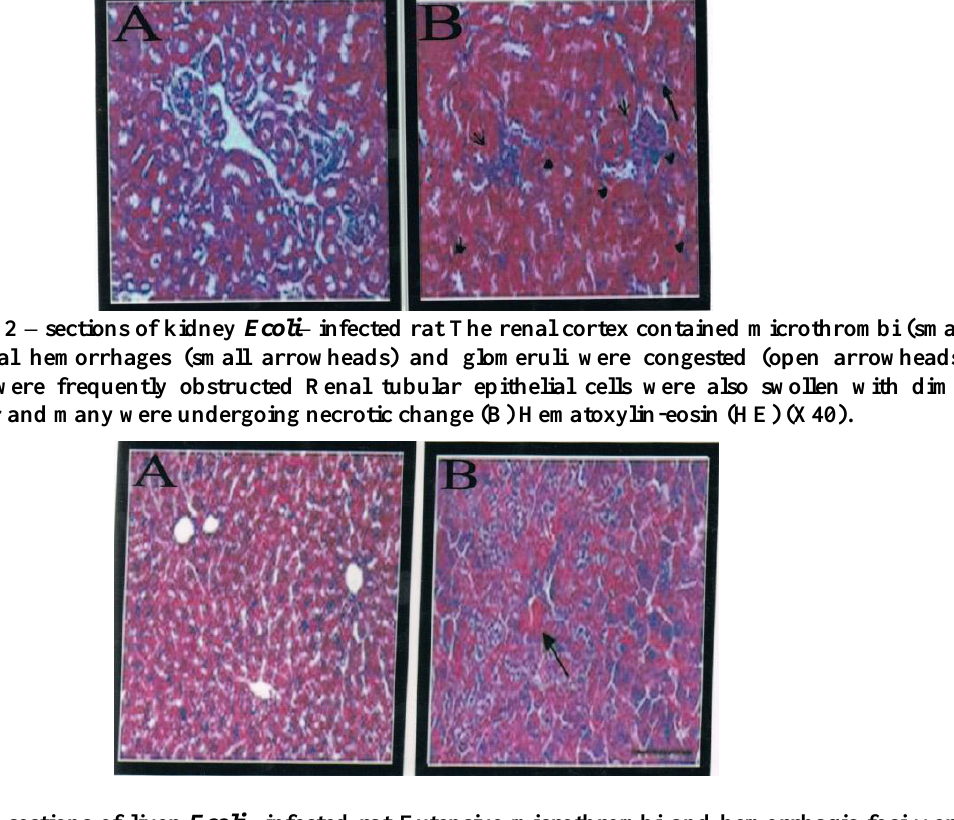
Figure 3 sections of liver Ecoli – infected rat Extensive microthrombi and hemorrhagic foci were found (large arrows) (B) Hematoxylin-eosin (HE) (X40).